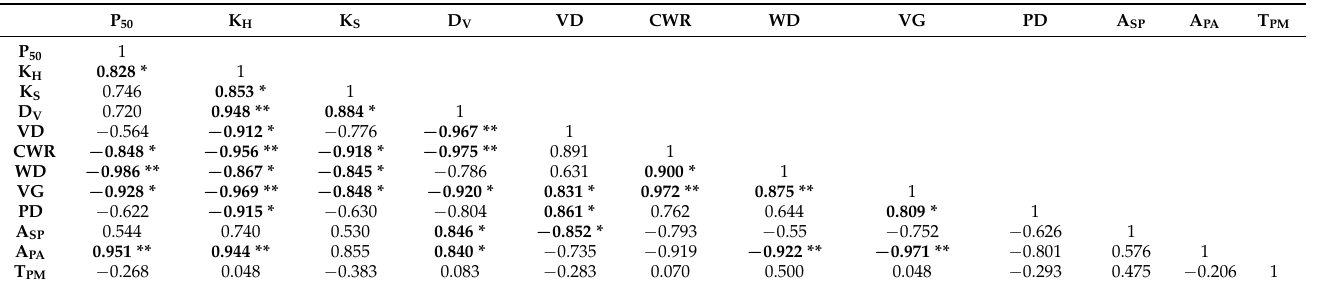
Table 2. Correlation matrix showing ‘R’ values between